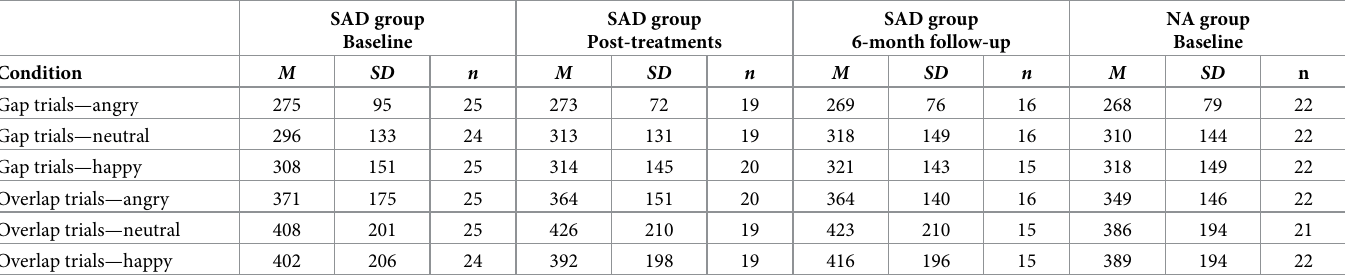
Table 2. Means and standard deviations (in milliseconds), and number of participants included in analyses, for latencies to fixate gaze on a peripherally appearing stimuli (gap trials) as well as latencies to disengage (avoidance) from a centrally located social stimuli (overlap